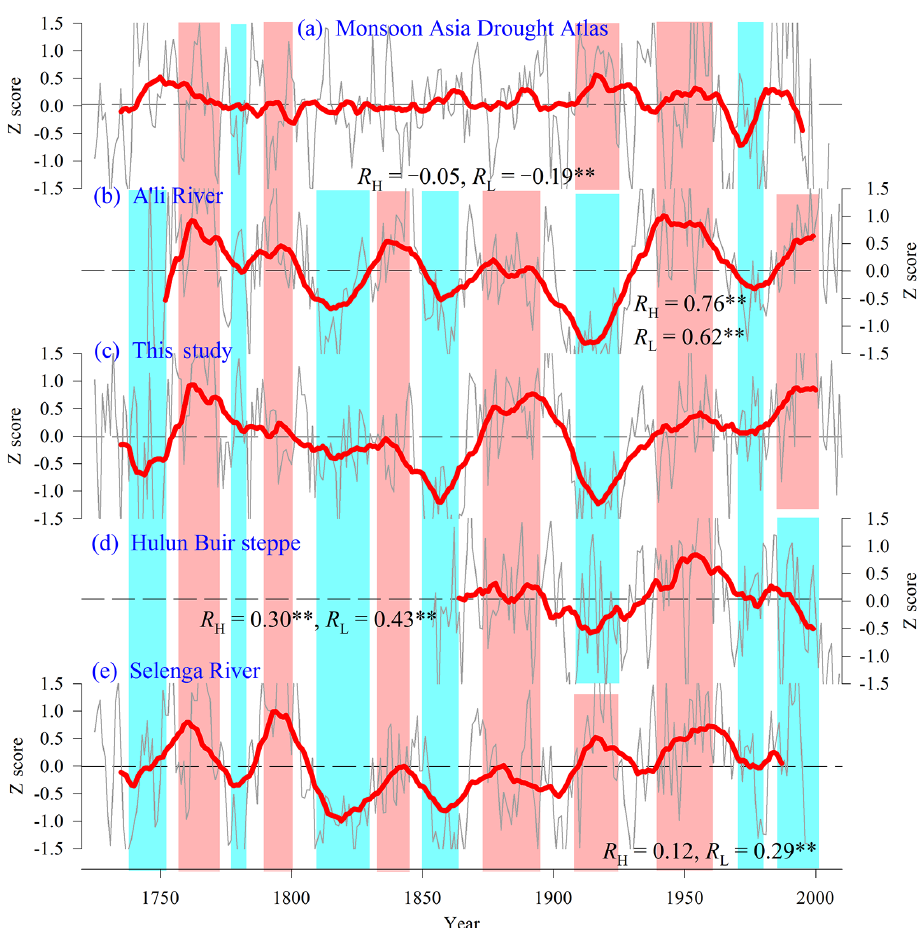
Figure 7. Comparisons of (a) the drought reconstruction derived from the Monsoon Asia Drought Atlas (MADA; Cook et al., 2010), (b) the winter precipitation reconstruction of the A’li River in northeastern China (AR; Lv and Wang, 2014), (c) the mean annual PDSI reconstruction in the Daxing’an Mountains (TS; in this study), (d) the April–August SPEI reconstruction of the Hulun Buir steppe in eastern Mongolian Plateau (HB; Bao et al., 2015) and (e) the April–October streamflow reconstruction of the Selenga River in northeastern Mongolia (SR; Davi et al., 2006). All above series were standardized using Z scores (high frequency) and then smoothed with a 21-year moving average (low frequency; red bold line). Blue and red shade areas represent a consistent period of drought and wetness, respectively. Correlation coefficients between our reconstruction series and other series in low ( R L ) and high ( R H ) frequency are shown on the diagram. ∗∗ p < 0 .